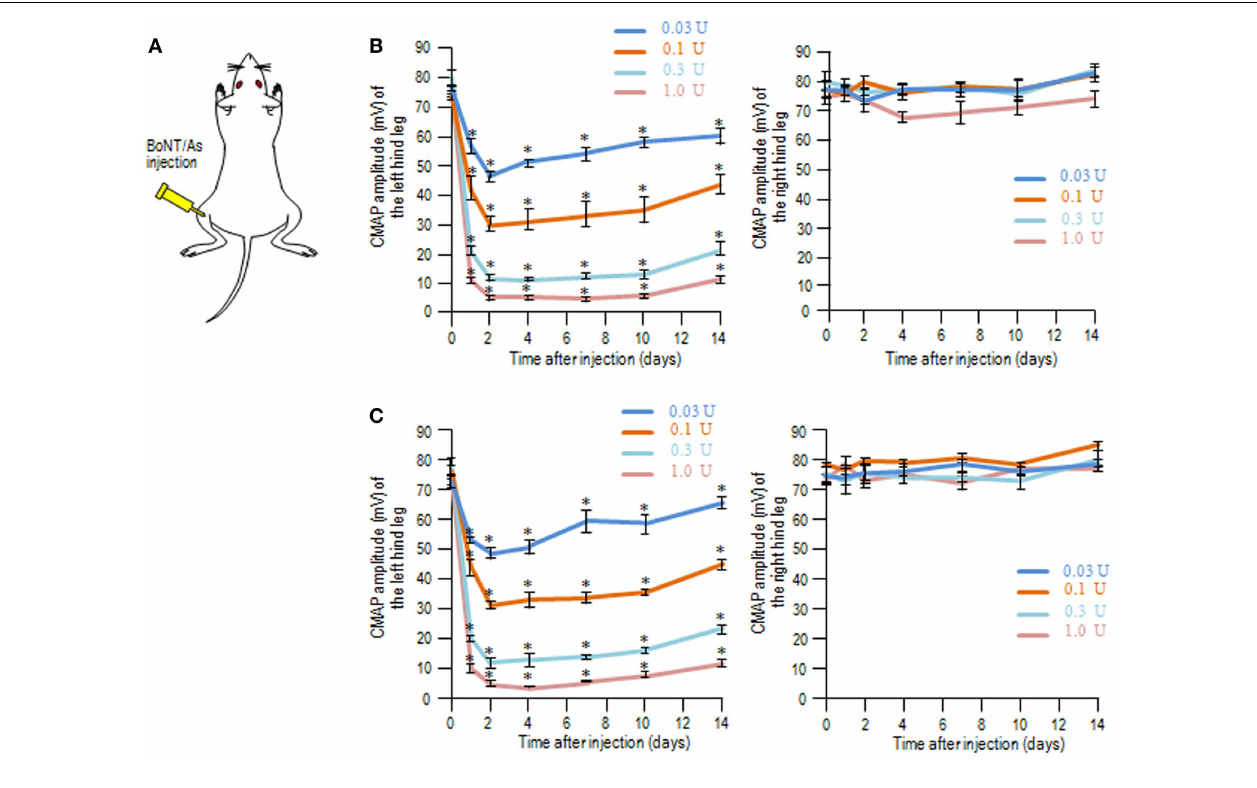
FIGURE 1 | Compound muscle action potential measurements following unilateral intramuscular injection of BoNT/A1 or BoNT/A2 at lower doses . (A) Experimental protocol. BoNT/A1 or BoNT/A2 was unilaterally injected into the left gastrocnemius muscle, and the CMAP amplitudes of both the hind legs were measured over time.